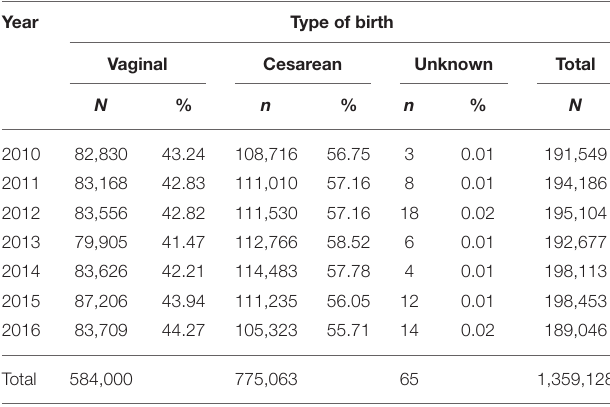
TABLE 1 | Distribution of number and percentage of types of birth, between the years of 2010 and 2016, in the city of São Paulo Source: SINASC/CEInfo/SMS-SP, 2018 (São paulo,